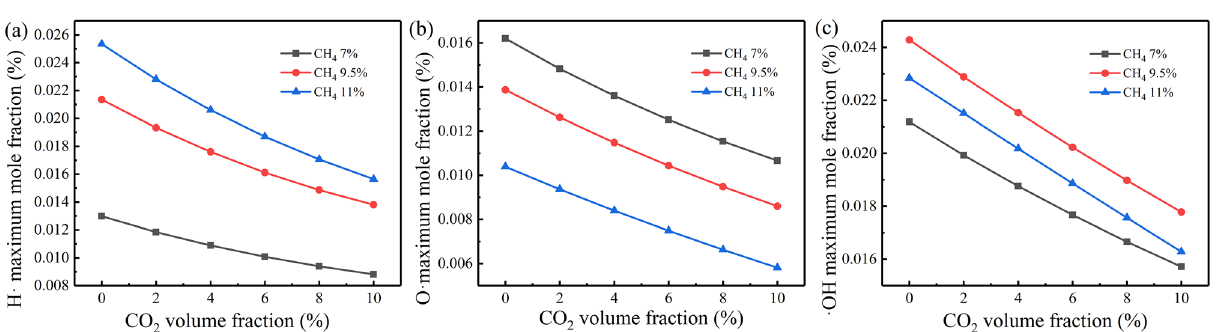
Figure 3. Variation of free radicals concentration with time under different CO 2 concentrations at 7% CH 4 : ( a ) free radical H, ( b ) free radical O, and ( c ) free radical OH.